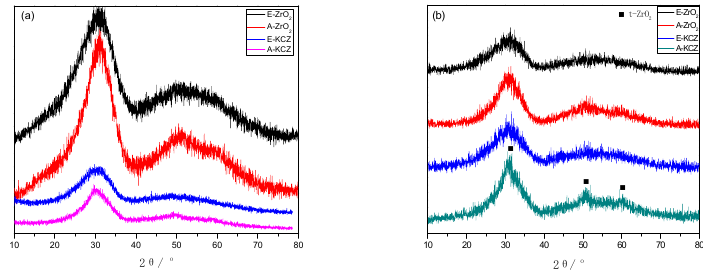
Figure 2. XRD patterns of ZrO 2 -based catalysts ( a ) fresh catalysts, ( b ) reduced catalysts.